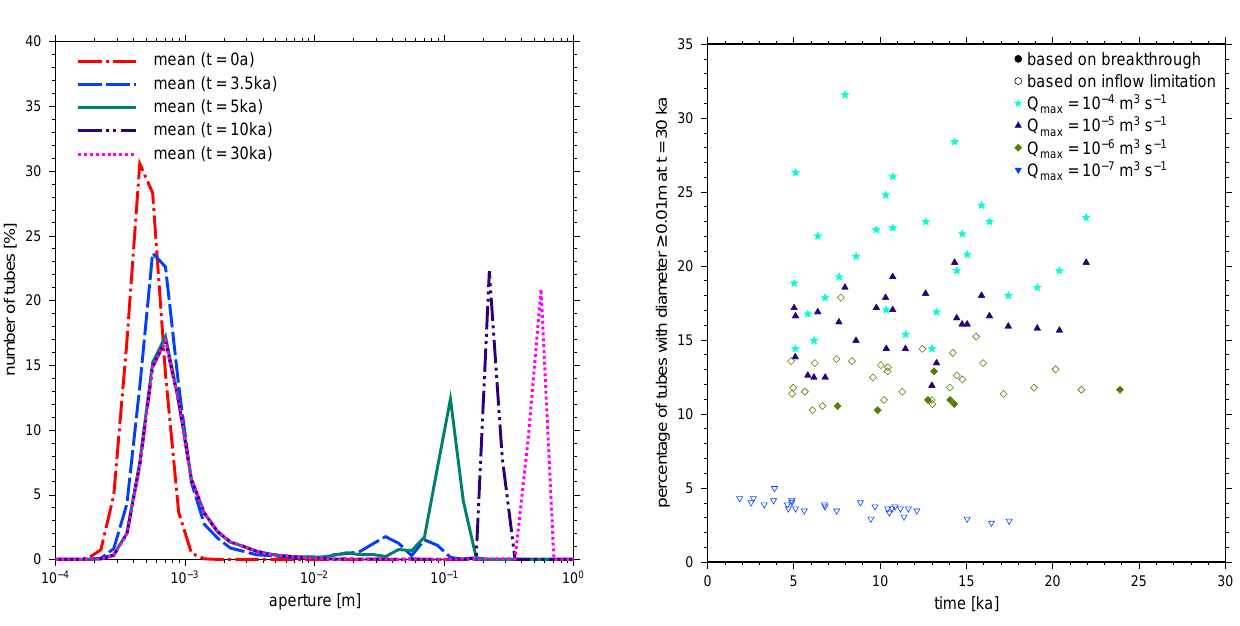
Fig. 7. Comparison of the percentage of large-aperture tubes ( a ≥ 0 . 01m) after 30ka with breakthrough time (filled symbols) and time when the constant maximum inflow rate is reached (open symbols) in selected high-heterogeneity scenarios ( σ 0 Note that for Q max = 10 − 4 m 3 s − 1 and Q max = 10 − 5 m 3 s − 1 both times practically coincide and that in the scenario with Q max = 10 − 6 m 3 s − 1 breakthrough occurs only in some realisations. Breakthrough does not occur in any realisation with Q max = 10 − 7 m 3 s − 1